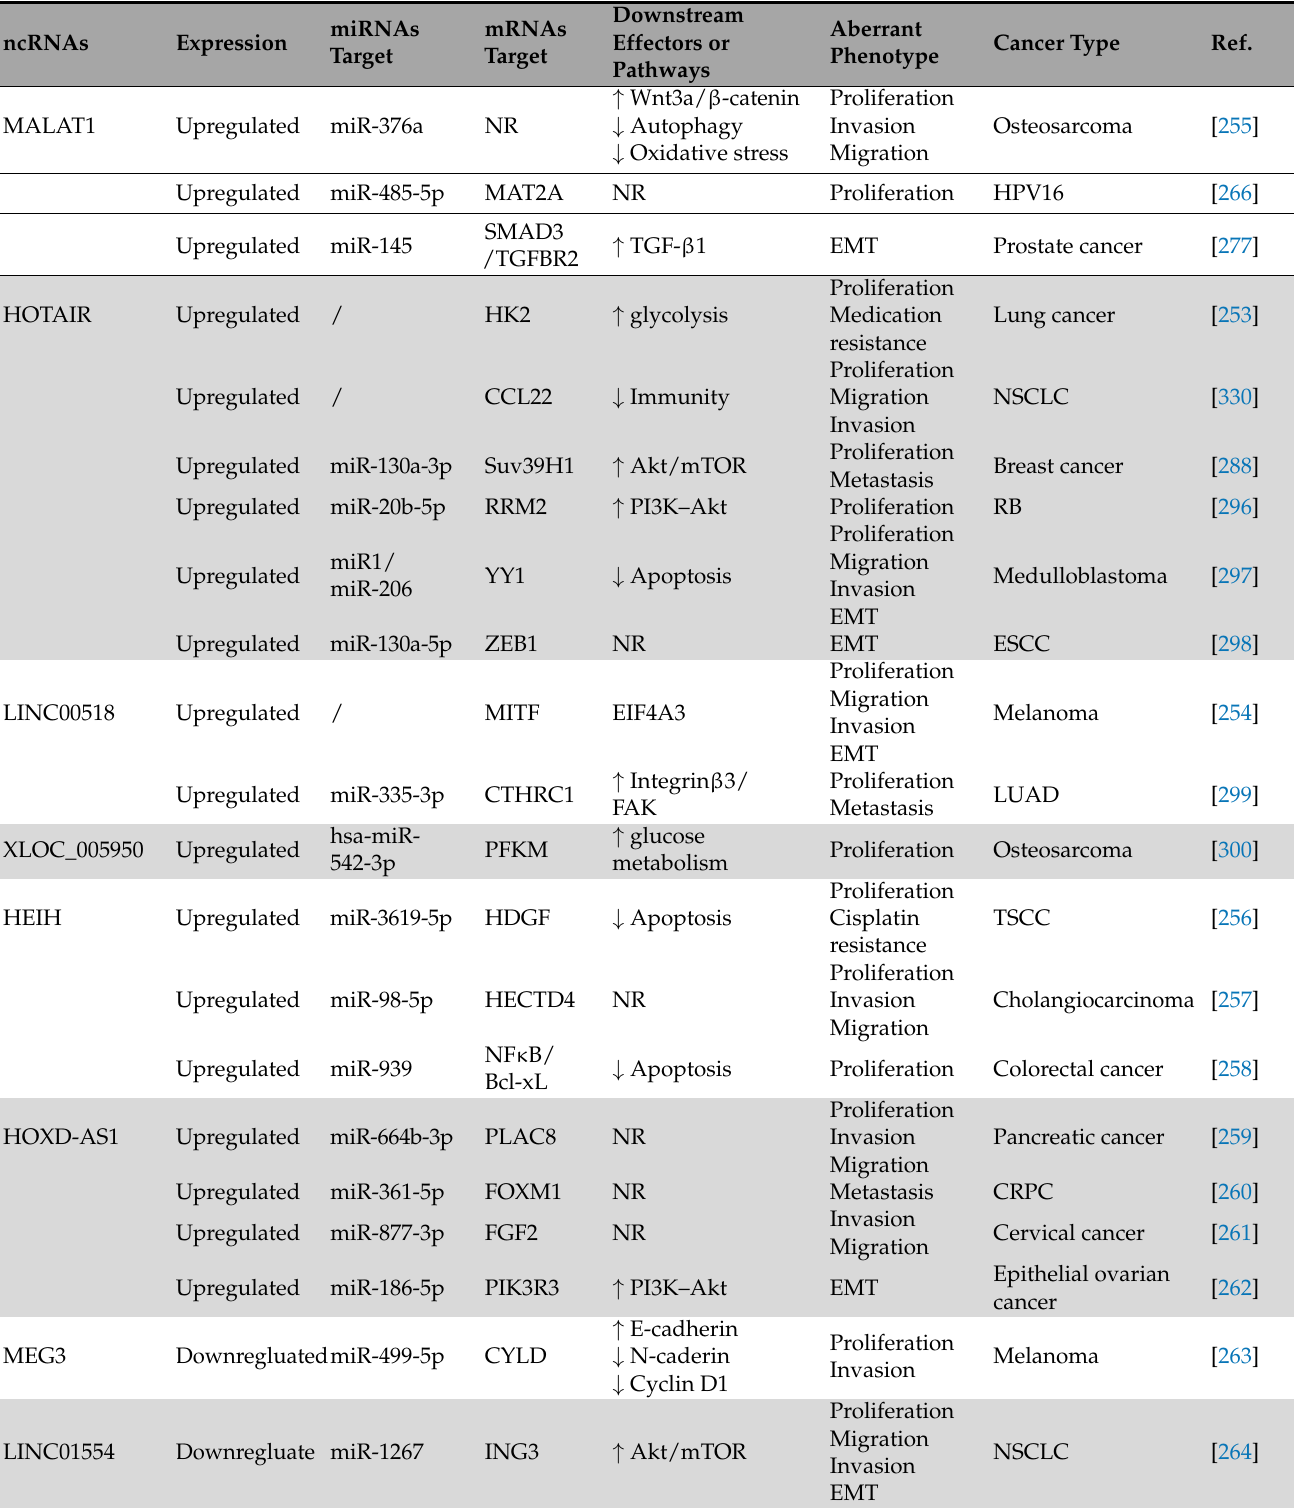
Table 1. The ncRNAs involved in tumorigenesis and drug